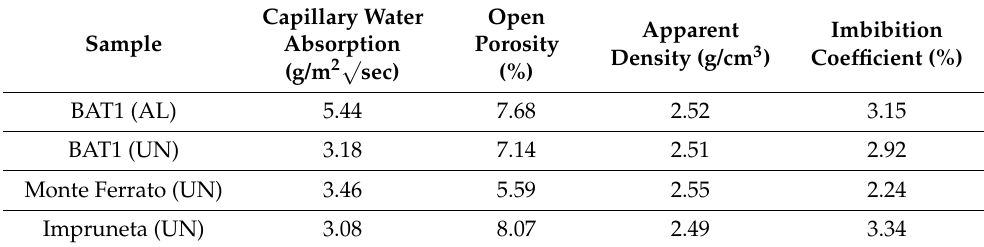
Table 4. Results of physical measurements (mean values).